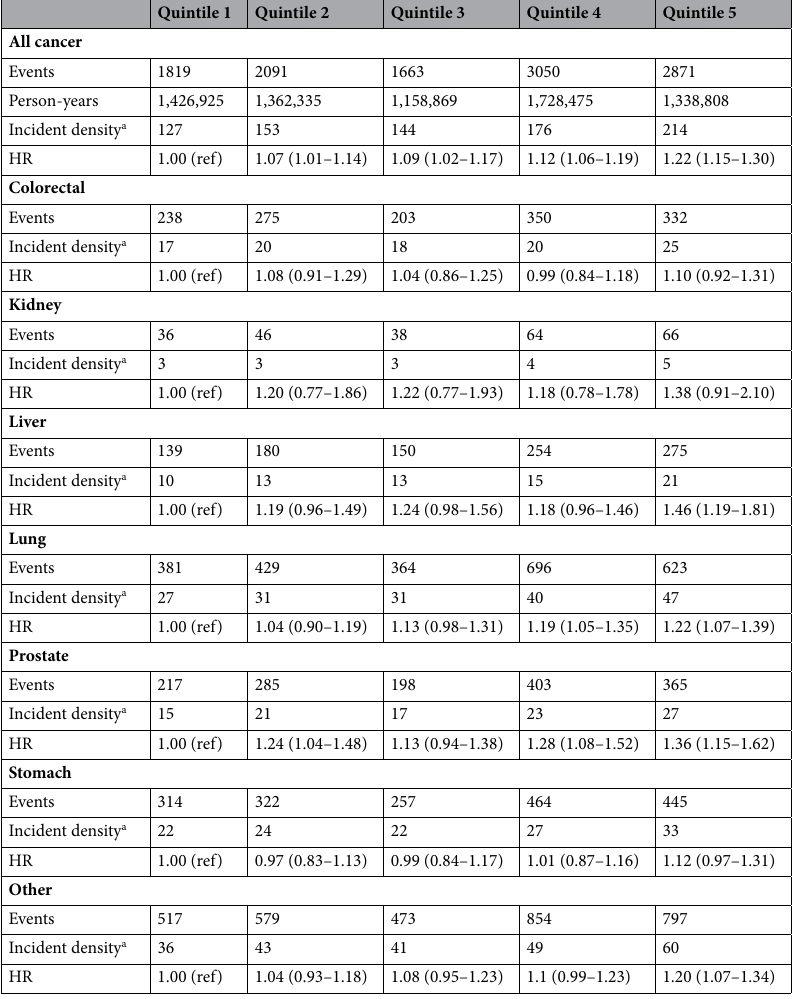
the BWV quintile increased, initial weight, mean weight and initial BMI increased, and the proportion of the subjects with weight gain or weight loss was greatest in the highest quintile BWV group (Table 1). Participants who had higher weight variability had higher fasting plasma glucose and total cholesterol, and the proportion of the subjects with hypertension, diabetes mellitus, and dyslipidemia also increased as the BWV quintile increased (36.14% and 41.66%, 8.50% and 11.76%, 12.45% and 13.80% for the lowest quintile (Q1) and the highest quintile (Q5), respectively). Current smokers and low-risk alcohol consumers were more likely to have greater weight variability, and those with moderate physical activity were more likely to have lower weight variability (Table 1). Associations between body weight variability and all cancers and site‑specific cancers. We checked PH assumption with a log negative log plot, and p-values were > 0.1. In unadjusted models and mini- mally adjusted model (adjusted for age only or adjusted for age and mean weight), the highest BWV group had a statistically significant higher risk of all cancers compared to the lowest quintile group (Supplementary 1). Table 2 presents the HRs for all cancers according to the BWV. The highest BWV group had a statistically significant higher risk of all cancers compared to the lowest quintile group (HR 1.22, 95% CI 1.15–1.30). The total incidence of lung cancer was 176 per 100,000 persons (21.6% of all cancers), which was the most common, followed by stomach cancer, prostate cancer, colorectal cancer, and liver cancer (128 (15.7%), 103 (12.7%), 100 (12.3%), and 72 (8.8%), respectively). The risks for liver cancer, lung cancer and prostate cancer in the highest BWV quintile were significantly greater than the risks in the lowest quintile (HR 1.46, 95% CI 1.19–1.81 in Q5; HR 1.22, 95% CI 1.07–1.39 in Q5; and HR 1.36, 95% CI 1.15–1.62 in Q5, respectively).